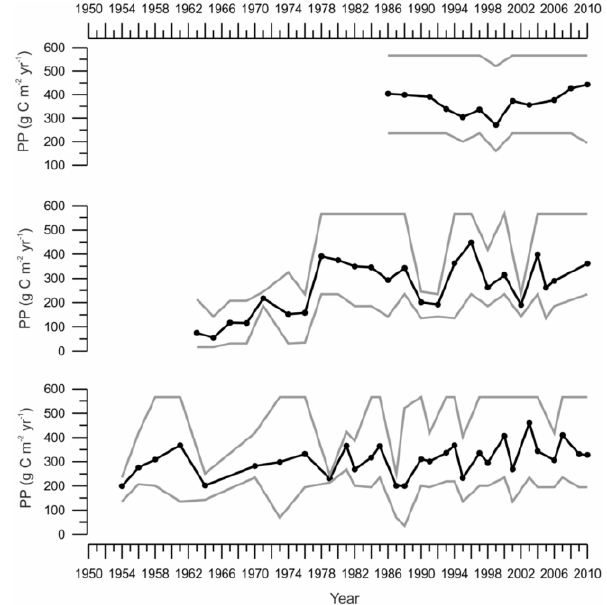
Fig. 9. Reconstructed primary productivity (gCm − 2 yr − 1 ) at every core site (black lines); grey surrounding lines: minimum and maxi- mum estimates for each reconstructed value calculated from the set of the 5 selected analogues.